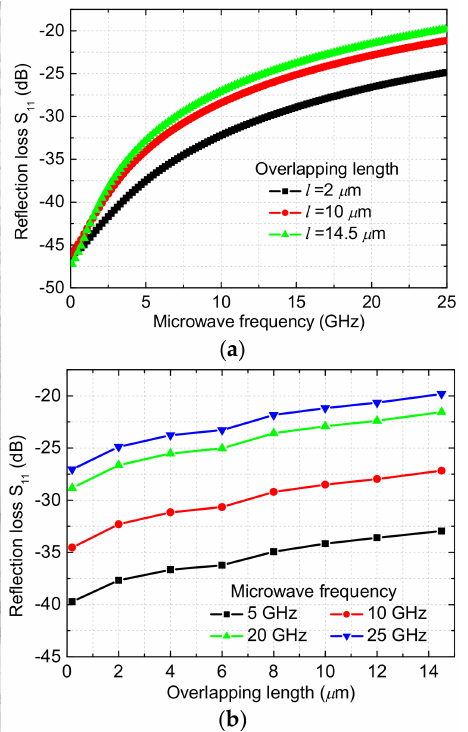
Figure 2. Simulated reflection losses of the GaAs MMIC-based power sensors. ( a ) S 11 versus microwave frequency at the fixed overlapping length of 2, 10, and 14.5 µ m and ( b ) S 11 versus the overlapping lengths at the fixed frequencies of 5, 10, 20, and 25 GHz.